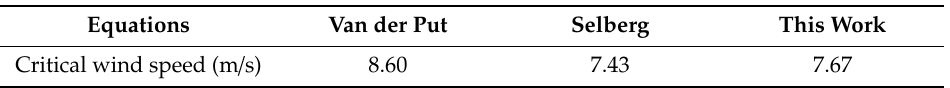
Table 3. The comparison of critical wind speed by different equations when there is no magnet attached to the PET membrane.